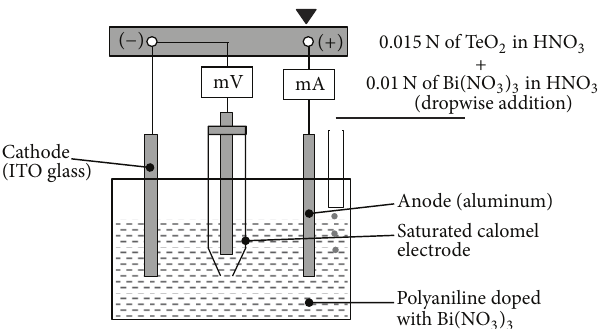
Figure 19: The schematic representation of electrochemical deposi- tion system for PANI/Bi 2 Te 3 [113].